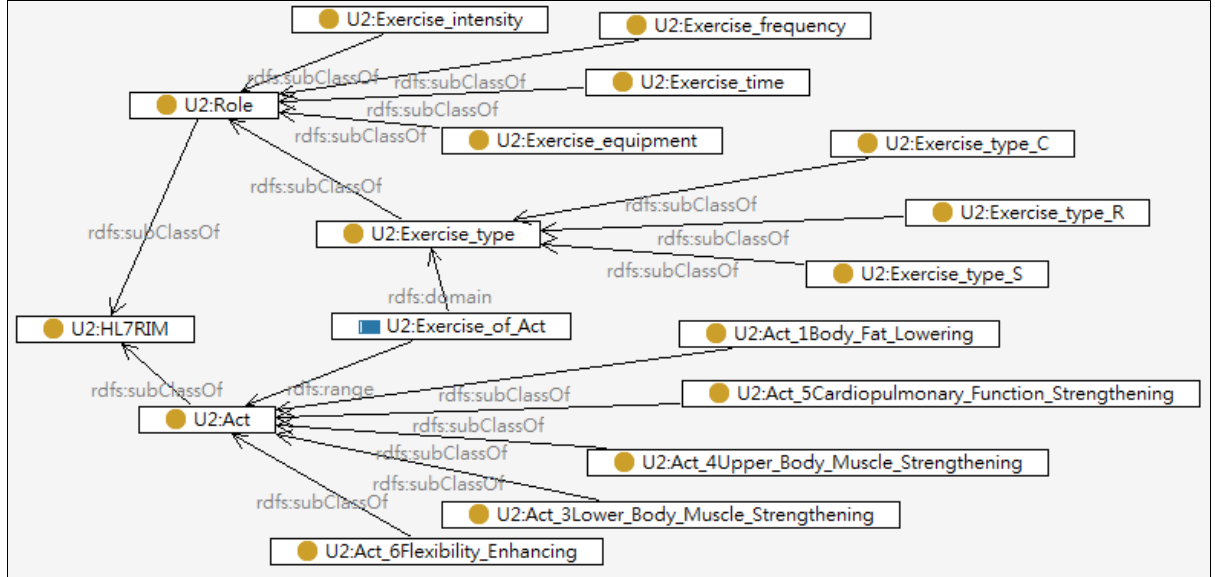
Figure 9. The partial model of Exercise